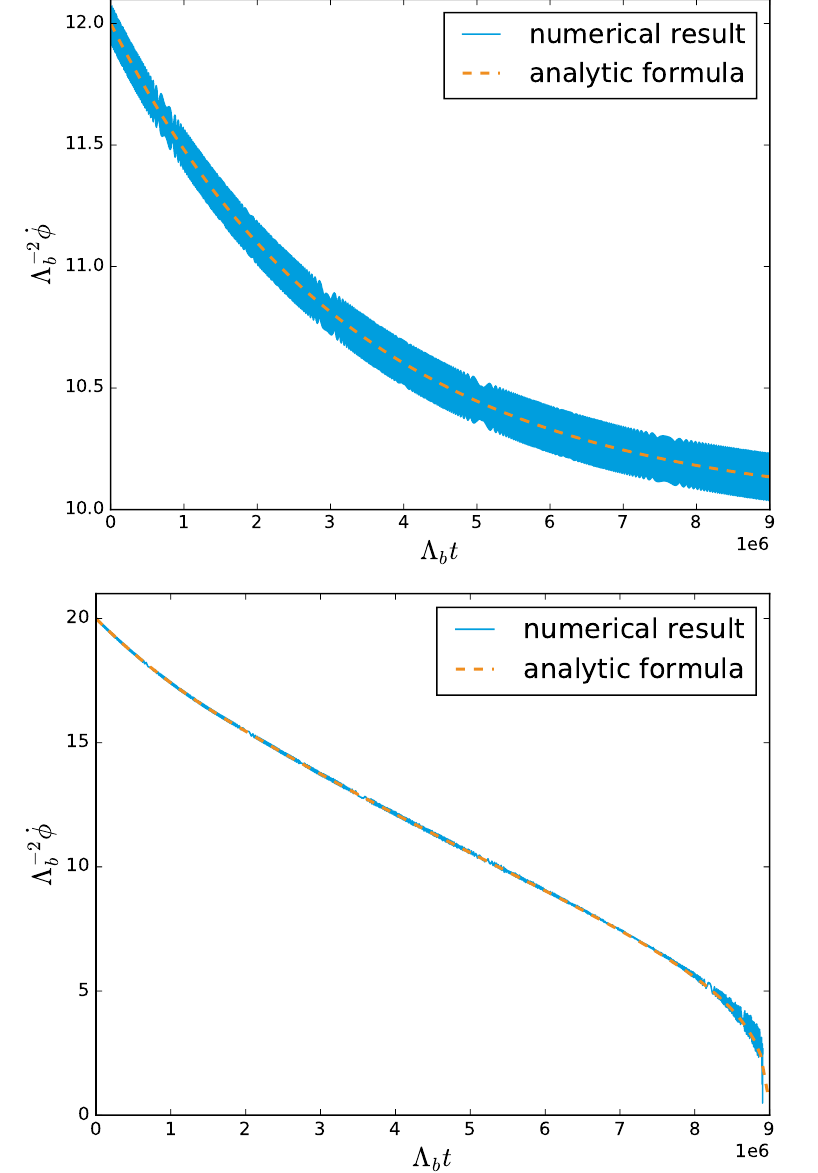
Figure 24 . Time evolution of _ (cid:30) . Here we take f = 10 3 , H = 10 (cid:0) 7 , and (cid:22) 3 = 3 (cid:2) 10 (cid:0) 6 in the unit of (cid:3) b = 1. Also, we take _ (cid:30) 0 = 12(cid:3) 2 in the upper panel and 20(cid:3) 2 in the lower panel. The blue lines b b are results of numerical calculations. The orange lines are obtained by integrating (cid:127) (cid:30) 3 in the upper panel and (cid:127) (cid:30) 1 in the lower